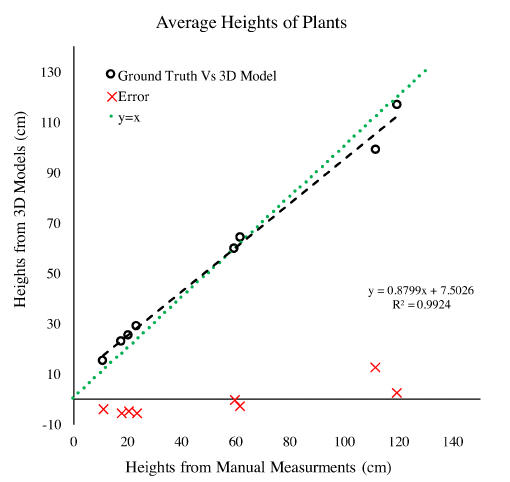
Figure 17. Comparison between manual measurements (Ground Truth) and 3D model based plant height at several time points during the growing season. The 3D model was created using RGB images captured by the